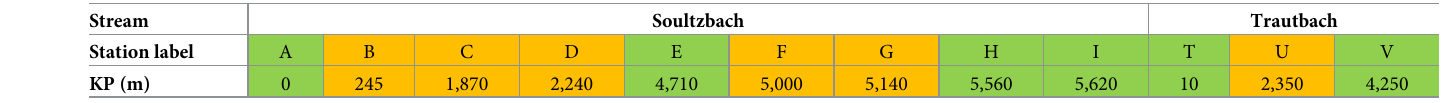
The kilometric point (KP) indicates distance from the stream source. Green background indicates forest landscape, while orange background indicates open grassland landscape. For the Soultzbach, the double vertical line indicates the presence of an